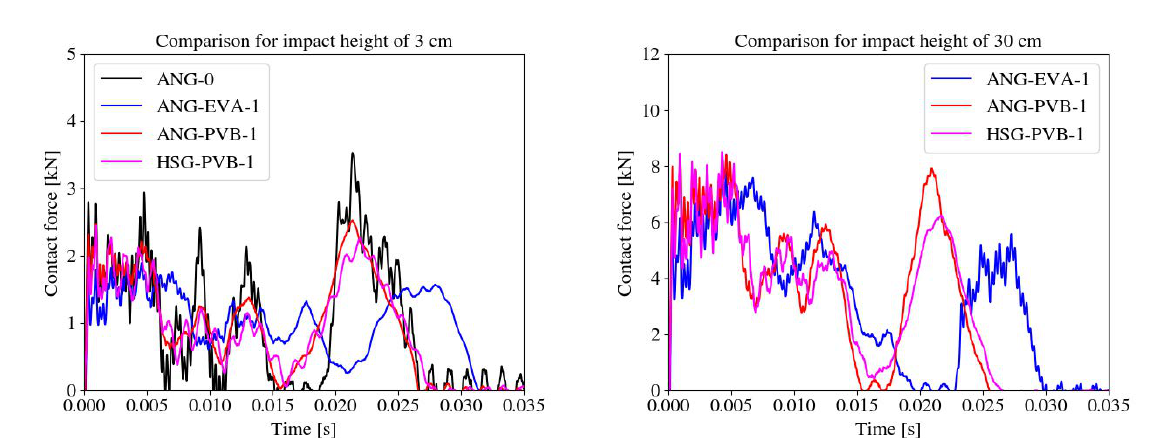
Fig. 7 Contact forces from experimental measurement derived from accelerations of the impactor for monolithic (ANG-0) and laminated (ANG-EVA, ANG-PVB, and HSG-PVB) glass samples for the impact height 3 cm or 30 cm.